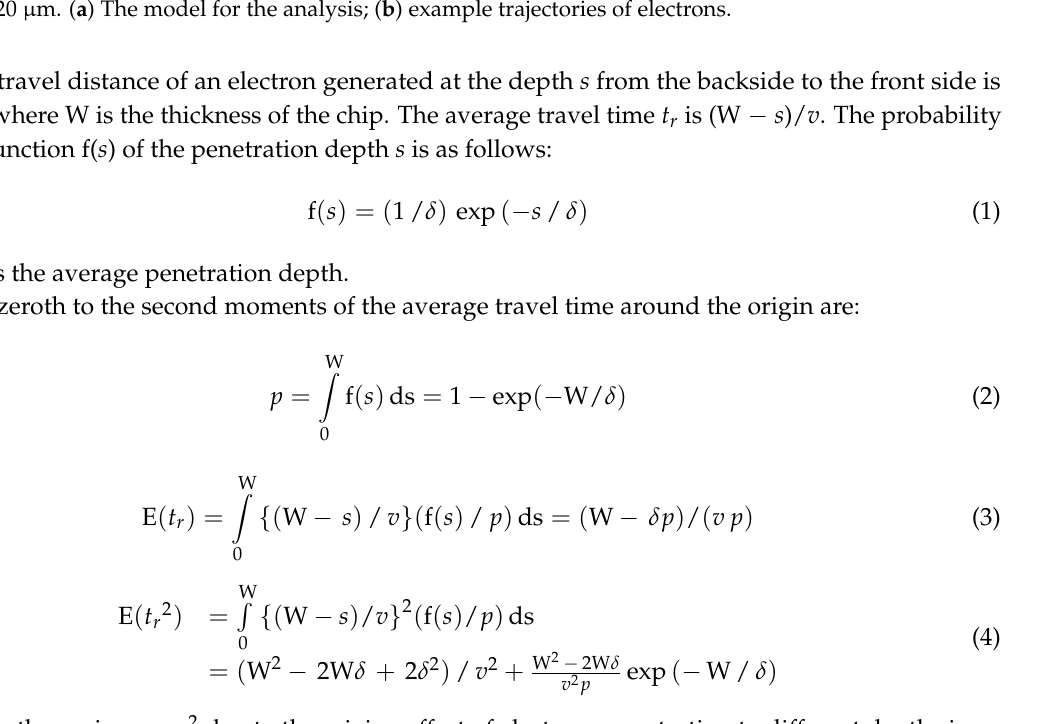
Figure 8. A cross-section structure for derivation of the standard deviation σ of the travel time for W = 20 µm. ( a ) The model for the analysis; ( b ) example trajectories of electrons.